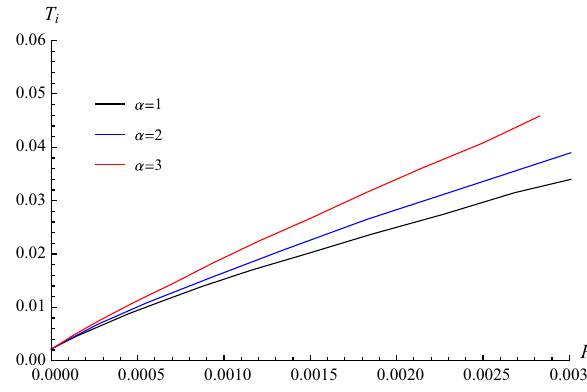
Fig. 7 Inversion curves P i − T i for heating process and cooling for different α . We set q =